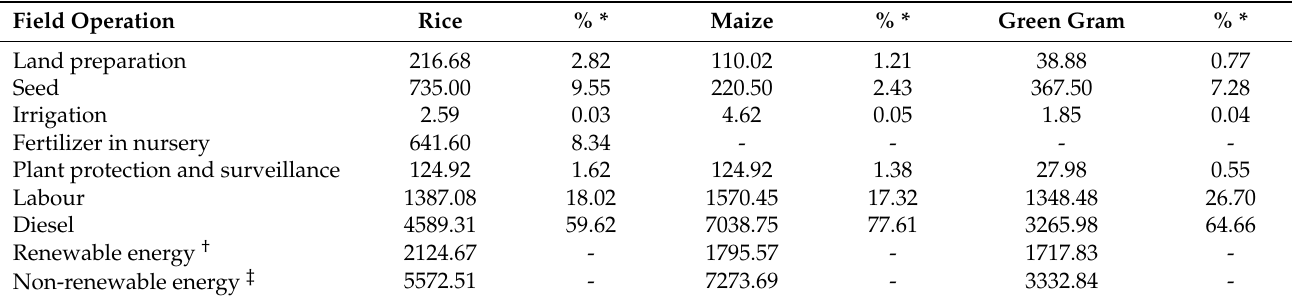
Table 4. The sources utilization of energy (in MJ ha − 1 ) for raising various crops under the rice–maize–greengram crop- ping